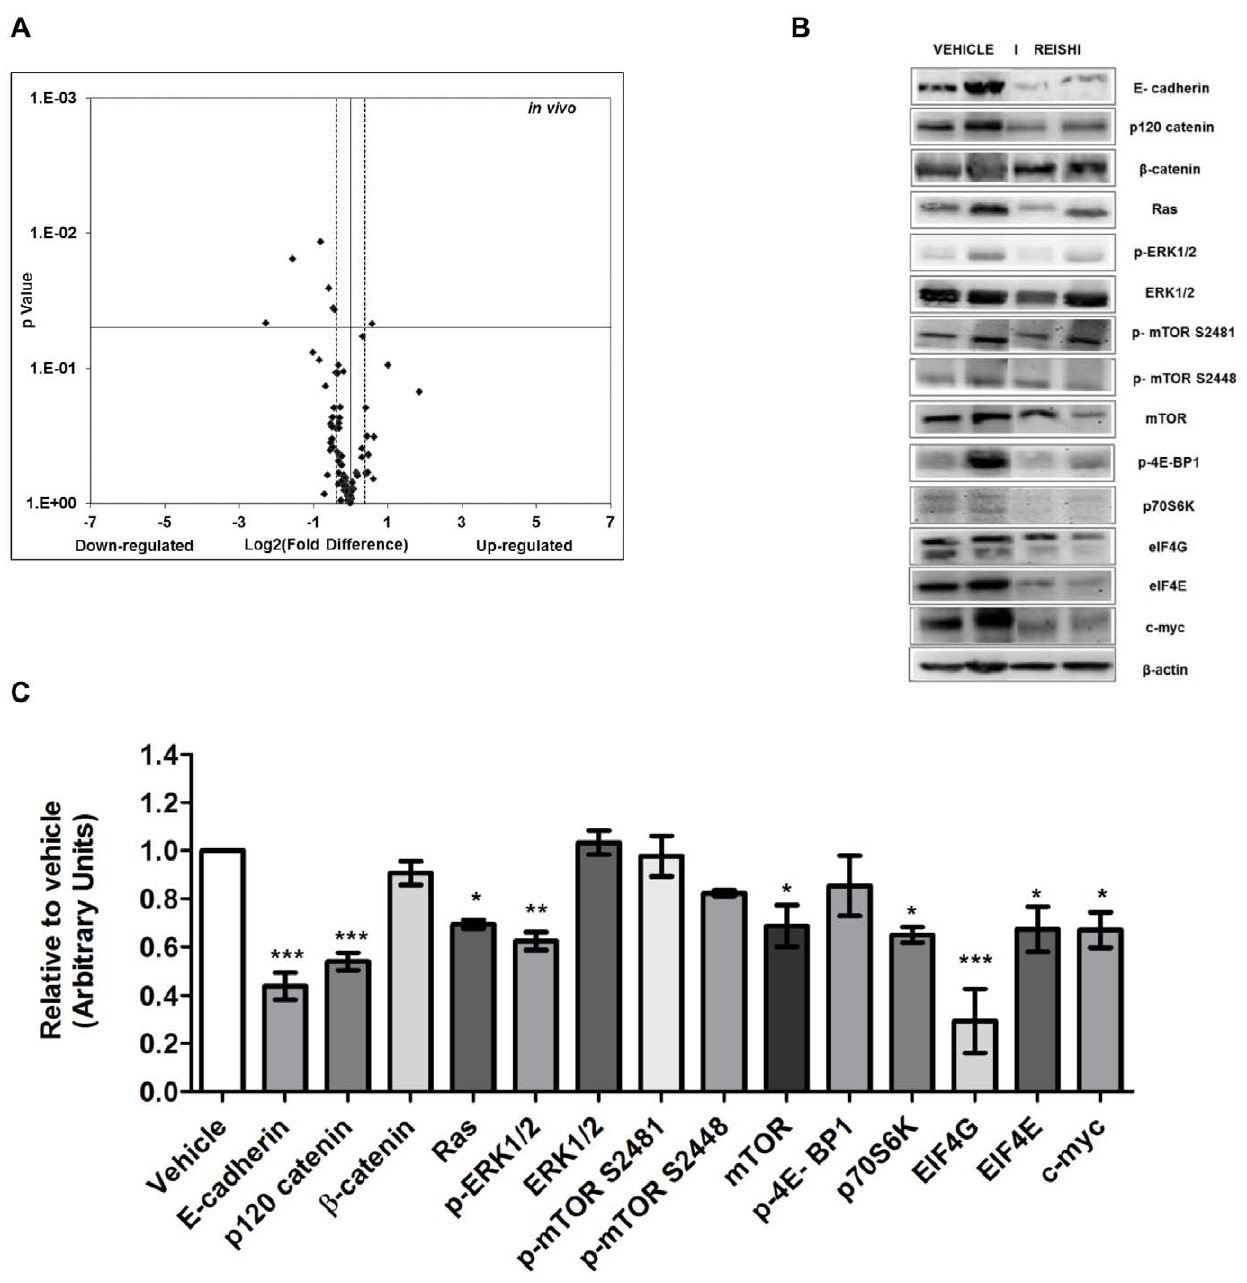
Figure 4. Reishi reduces PI3K/AKT/mTOR and MAPK pathway gene and protein expression. A. RT 2 PCR array designed to profile the expression of PI3K/AKT pathway-specific genes was performed using 500 ng of tumor extracted RNA, according to manufacturer’s instructions (SA Biosciences). Volcano plot show effects on gene expression analyzed at 2 1.3 $ 1.3 log 2 -fold change (dashed line). Down-regulated genes are to the left of the vertical black line while up-regulated genes are to the right. Statistically significant regulated genes are above the horizontal black line at P , 0.05. B. Equal amount of protein from each sample was used for western blot analysis with antibodies against key IBC proteins. Each lane depicts a representative tumor lysate from a different mouse of either vehicle or Reishi treatment. C. Quantification was done using integrated density units, normalized to b -actin and relative to vehicle. Columns show means 6 SEM. Reishi downregulates the expression of key IBC proteins in vivo. * P , 0.05, ** P , 0.01. reduced protein synthesis by half in IBC cells, an effect not seen in Reishi treated MCF10A cells. Therefore, these results support the hypothesis that Reishi has a selective anti-cancer effect that is manifested by downregulating the mTOR pro-survival pathway and ultimately protein synthesis.